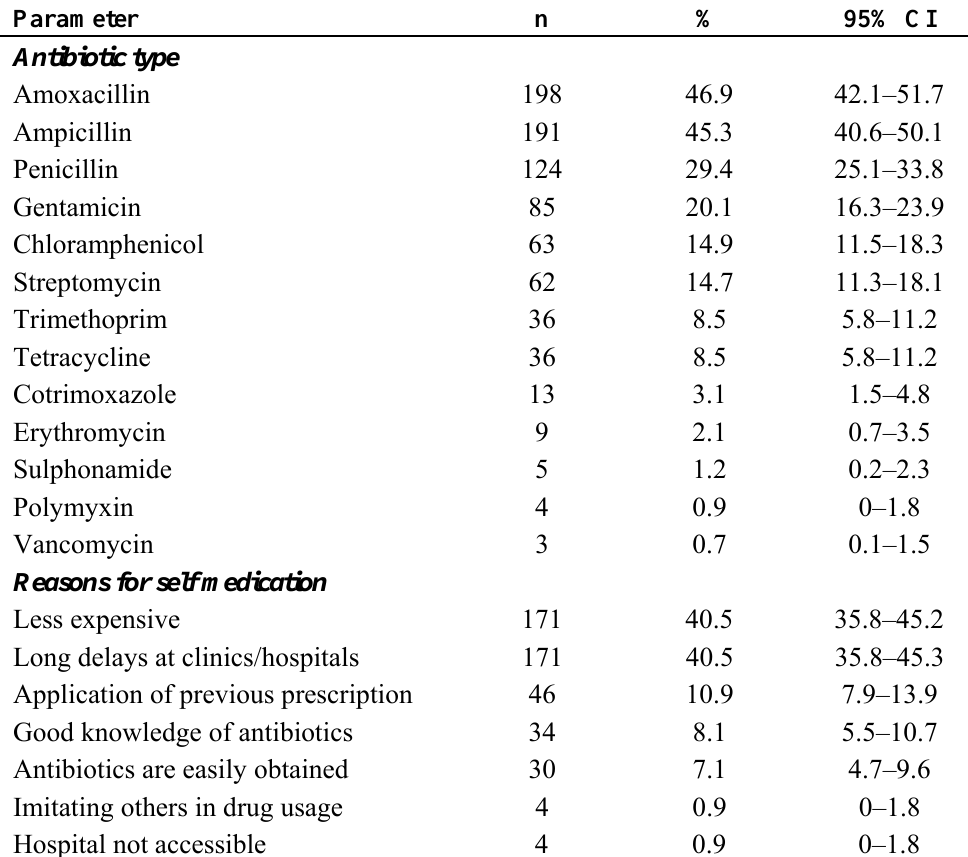
Table 3. Antibiotics used and reasons cited for self